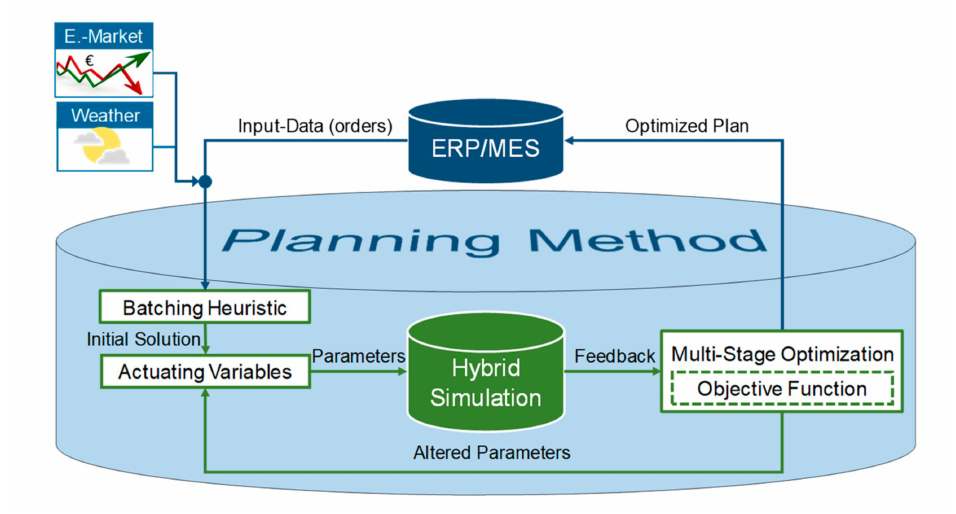
Figure 2. Overview of the optimization